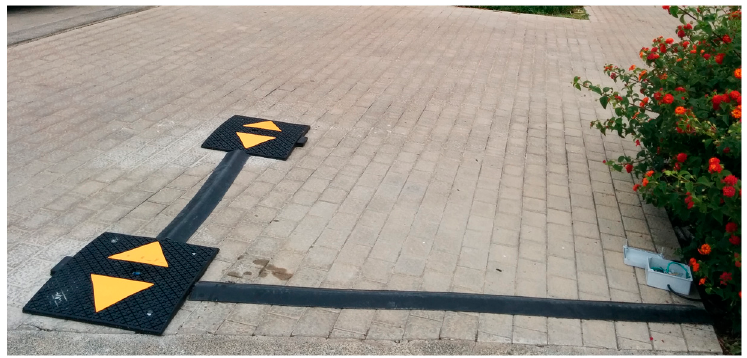
Figure 7. Deployment of the sensors.